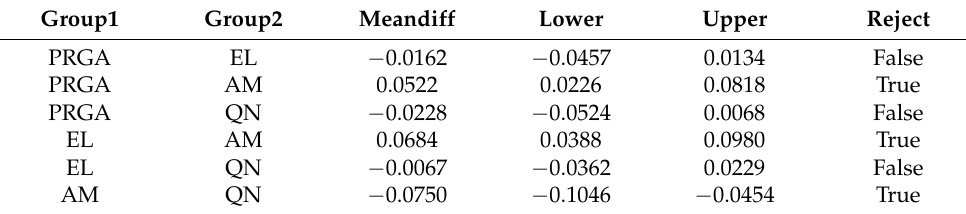
Table 10. Multiple comparisons of means: Tukey HSD, FWER = 0.05—simulated